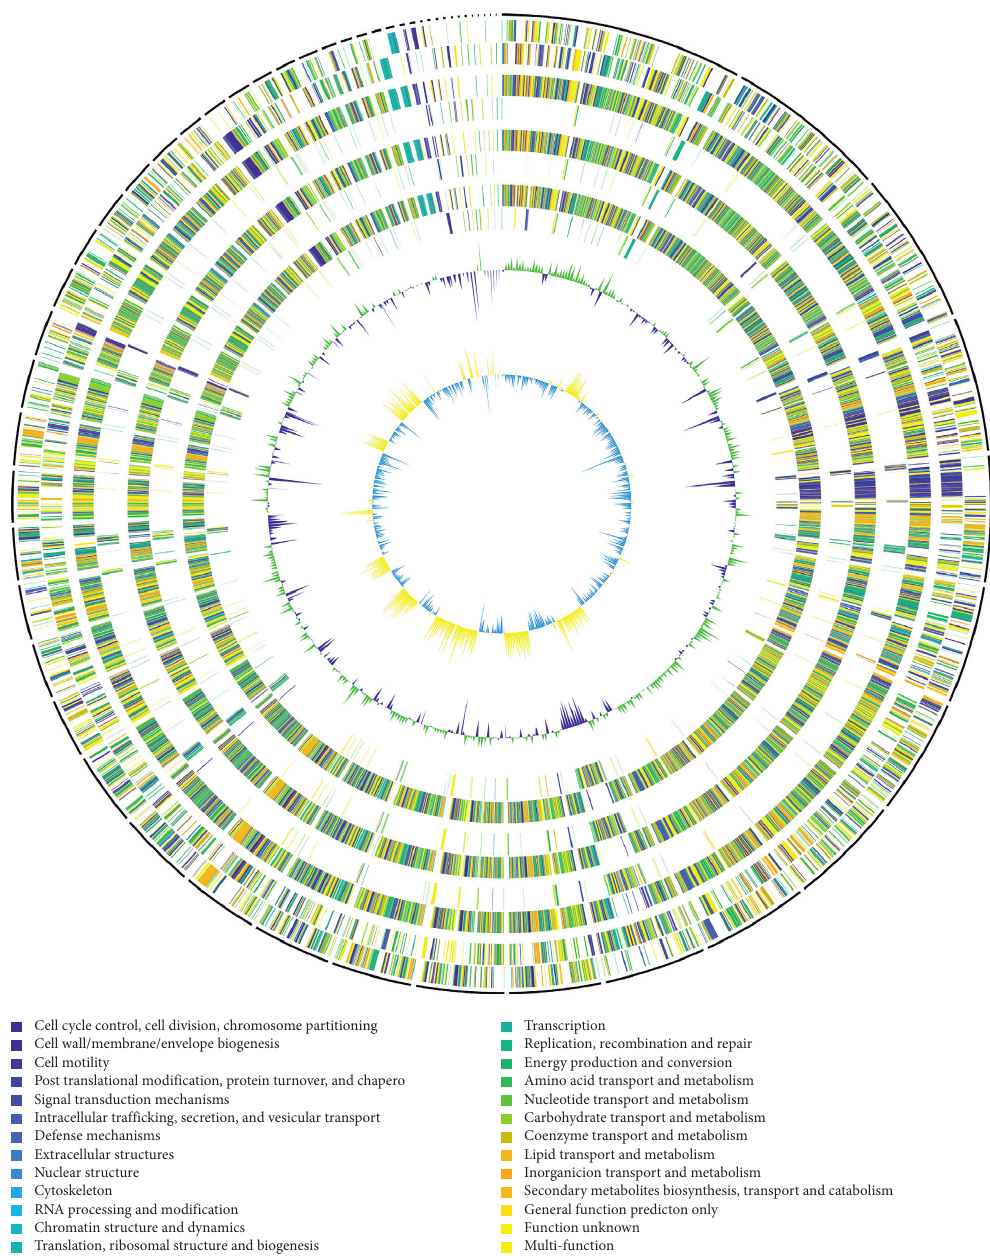
Figure 2: Circular genomes representation map and genome comparison of Shewanella algae (CHL, ACCC, MARS 14, and YHL). Predicted coding sequences (CDSs) are assigned various colors with respect to cellular functions. Circles show, from the outermost to the innermost, (1) DNA coordinates; (2, 3) function-based color-coded mapping of the CDSs predicted on the forward and reverse strands of the S. algae CHL genome, respectively; (4) orthologous CDSs shared between S. algae CHL and S. algae ACCC; (5) S. algae CHL-specific CDSs, compared with S. algae ACCC; (6) orthologous CDSs shared between S. algae CHL and S. algae MARS 14; (7) S. algae CHL-specific CDSs, compared with S. algae MARS 14; (8) orthologous CDSs shared between S. algae CHL and S. algae YHL; (9) S. algae CHL-specific CDSs, compared with S. algae YHL; (10) GC plot with regions above and below average in green and violet; (11) GC skew showing regions above and below average in yellow and light blue. This figure was plotted in Scalable Vector Graphics format via an in-house script, which calculates the radius and ribbon width according to the BLAST alignments and adds colors by COG classification of all orthogonal